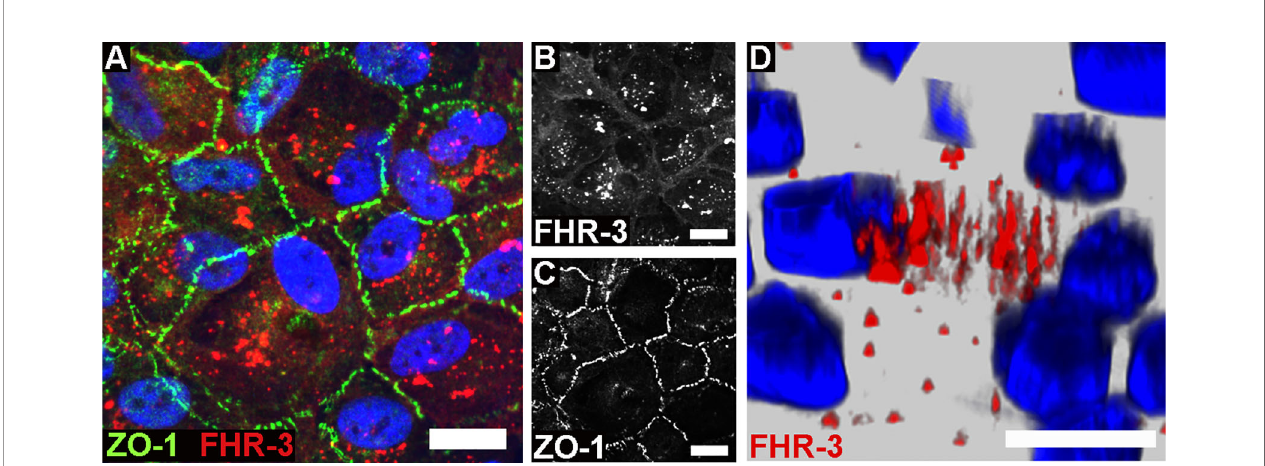
FIGURE 1 | FHR-3 was internalized by ARPE-19 cells. Polarized, differentiated ARPE-19 cells were apically treated with FHR-3. (A) FHR-3 was speci fi cally detected after 2 h incubation time by anti-FHR-3 antibody RETC-2 [red, (B) ], cell-cell connections were labelled with anti-ZO-1 antibody [green, (C) ]. Magni fi cation 200x.